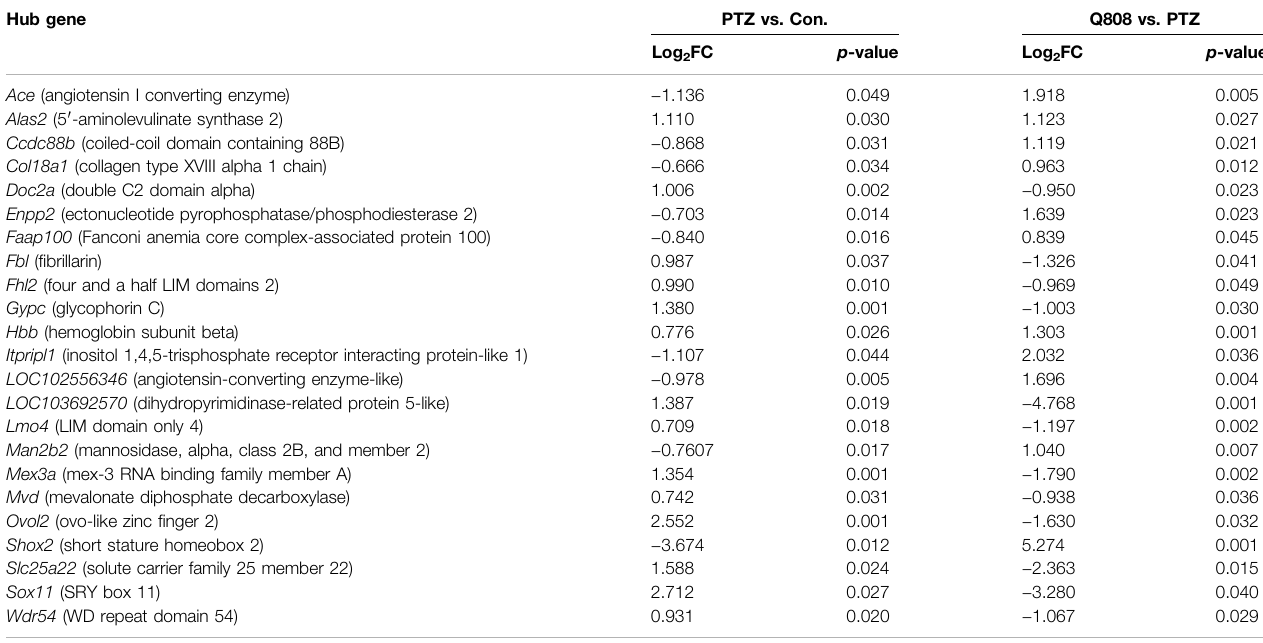
TABLE 2 | Information of 23 hub genes identi fi ed by RNA-seq analysis across the three groups. Hub gene PTZ vs. Con. Q808 vs. PTZ Log 2 FC p -value Log 2